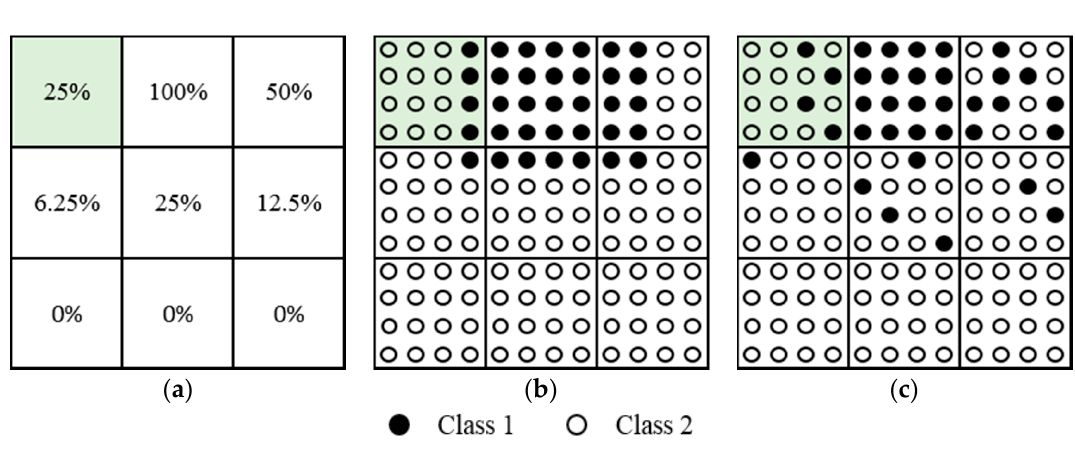
Figure 1. Example of the sub-pixel mapping problem: ( a ) A 3 × 3 grid coarse pixel divided into 16 sub-pixels (4 × 4), with the scale factor of 4; ( b ) The optimal sub-pixel distribution of one class; and ( c ) The possible sub-pixel distribution of one class.